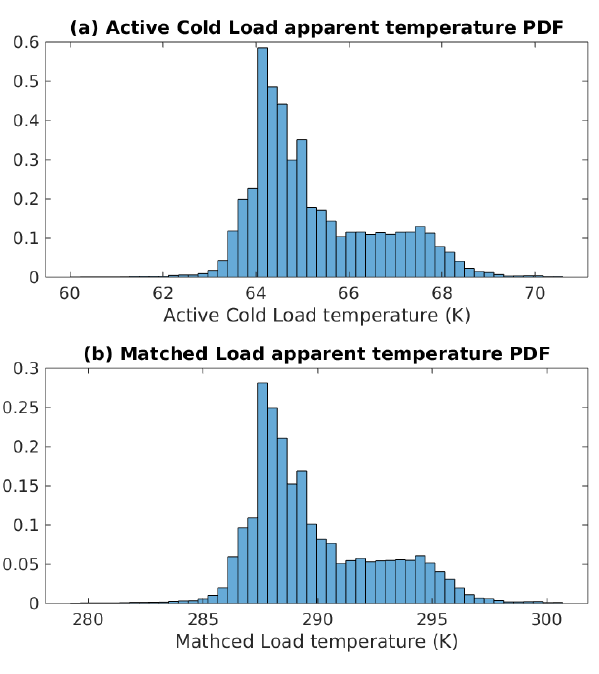
Figure 3. ( a ) Active Cold Load apparent temperature (Kelvin), and ( b ) Matched Load apparent temperature